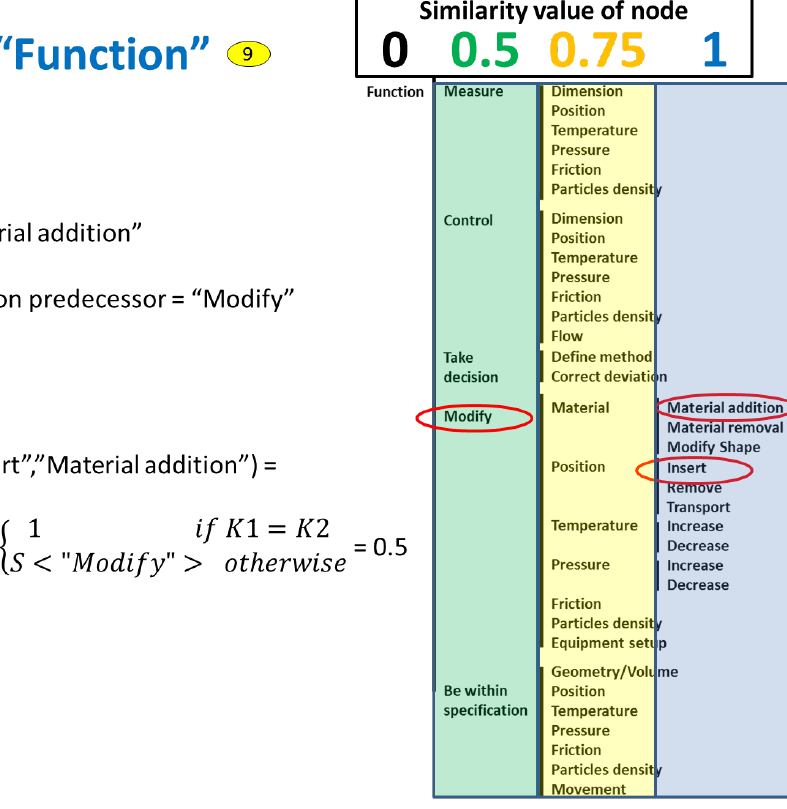
Figure 12. Example of individual similarity for taxonomy attributes.